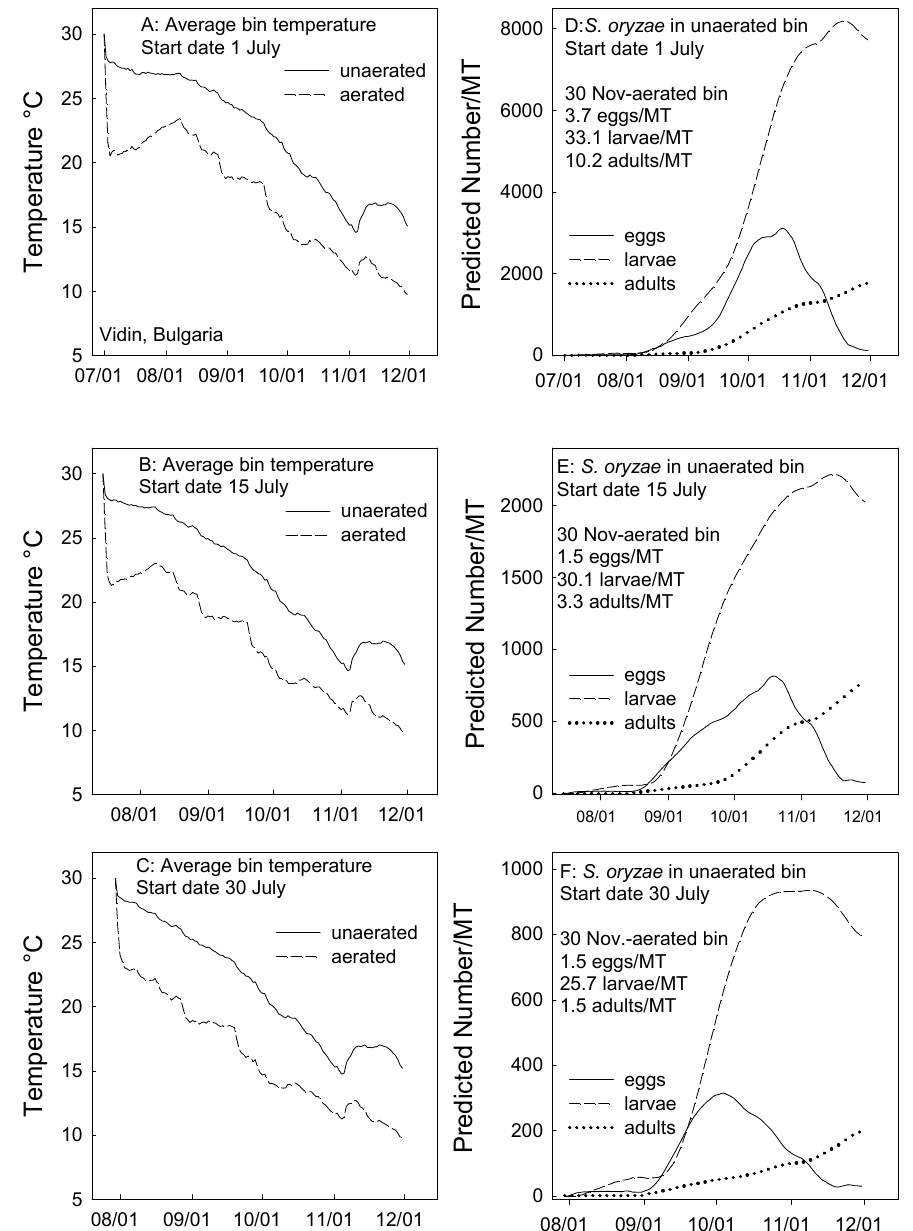
Figure 3. Predicted average bin temperatures in unaerated (solid line) and aerated wheat (dashed line) for wheat stored in Vidin, Bulgaria, with start dates of 1, 15, and 30 July ( A – C ). Predicted populations of eggs, larvae, and adult S. oryzae (solid line, dashed line, dotted line, respectively) in unaerated wheat with those start dates are plotted in ( D – F ). Data for predicted populations of eggs, larvae, and adults in aerated wheat are given as text inside ( D – F ).